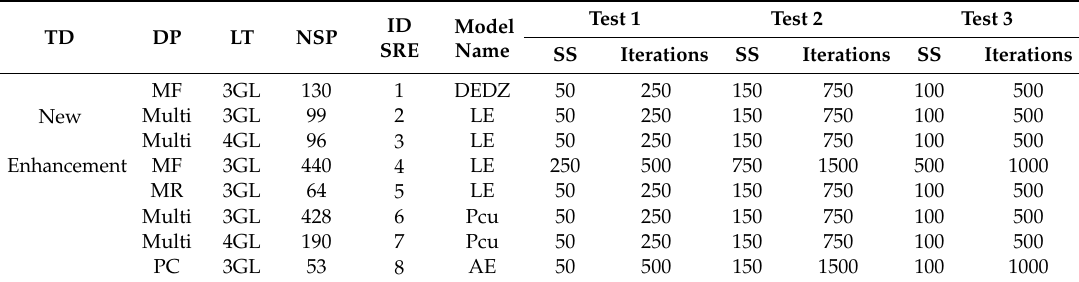
Table 8. PSO parameters by data set (TD: type of development, DP: development platform LT: